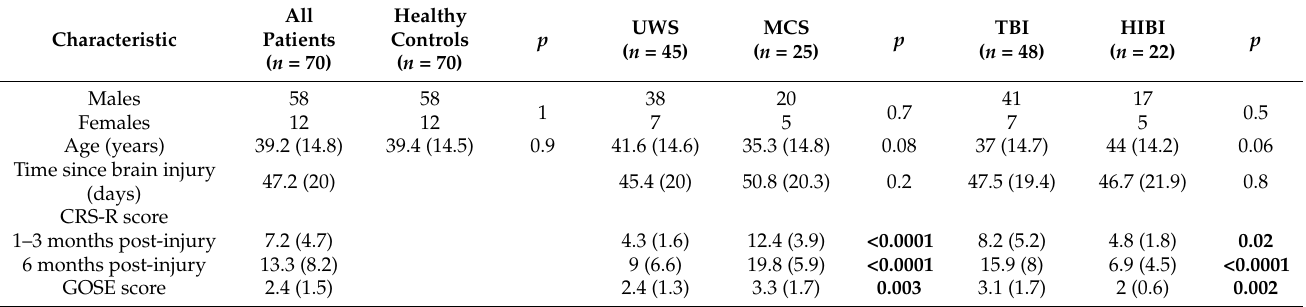
Table 1. Participant characteristics.